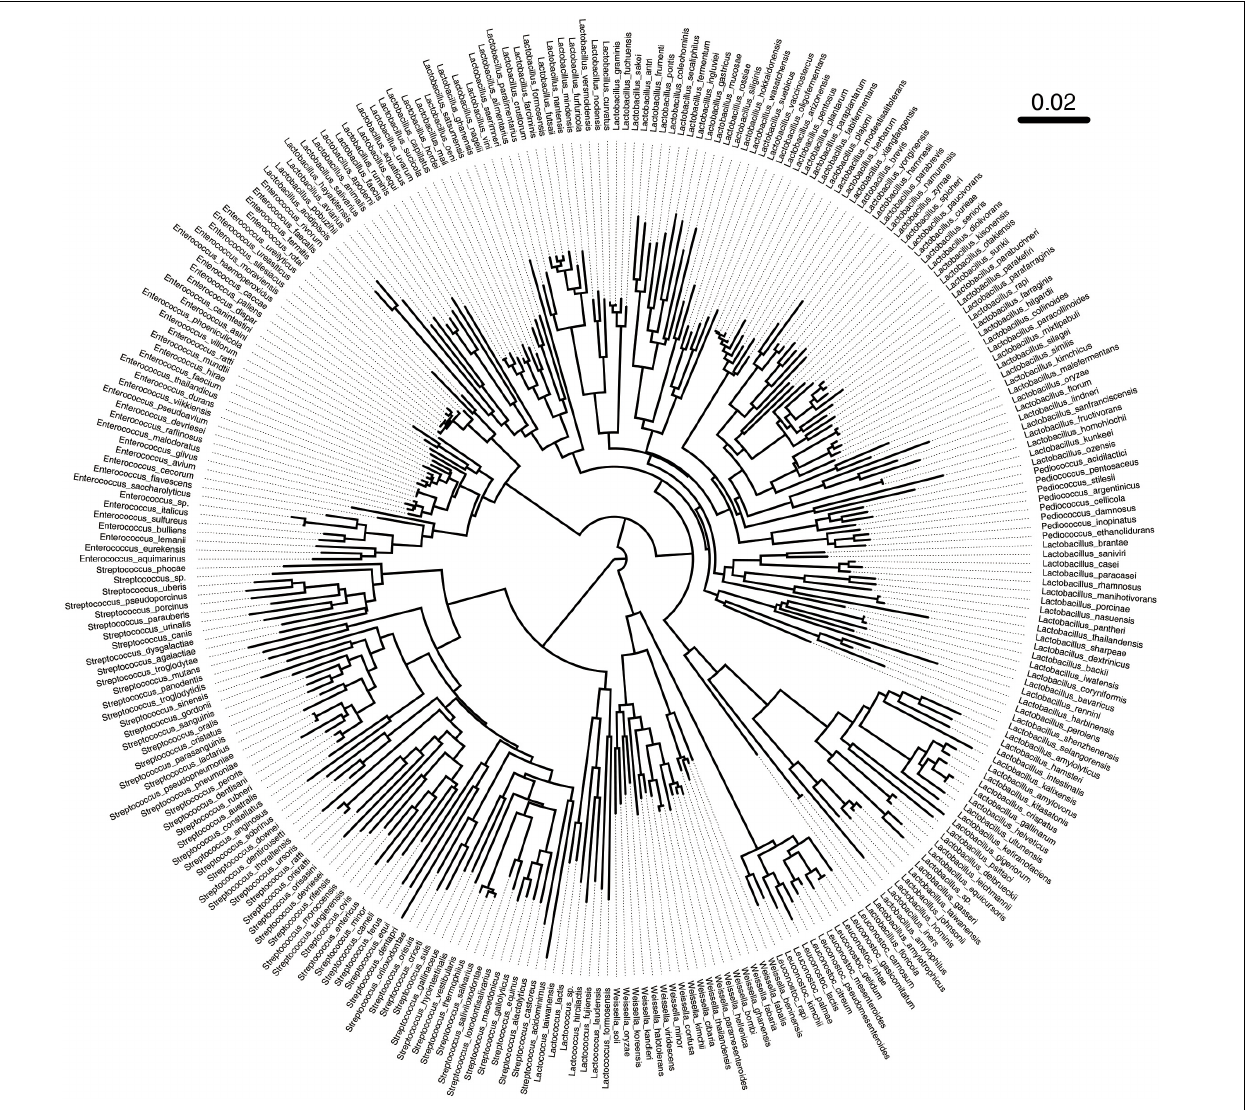
FIGURE 5 | Phylogenetic tree based on sequences between the forward and reverse primer L5. A total of 347 sequences between the forward and reverse primer of L5 were obtained in LABSEQ. A phylogenetic tree was constructed based on these sequences using TreeBeST software (V1.9.2). Visual trees were then developed using FigTree software